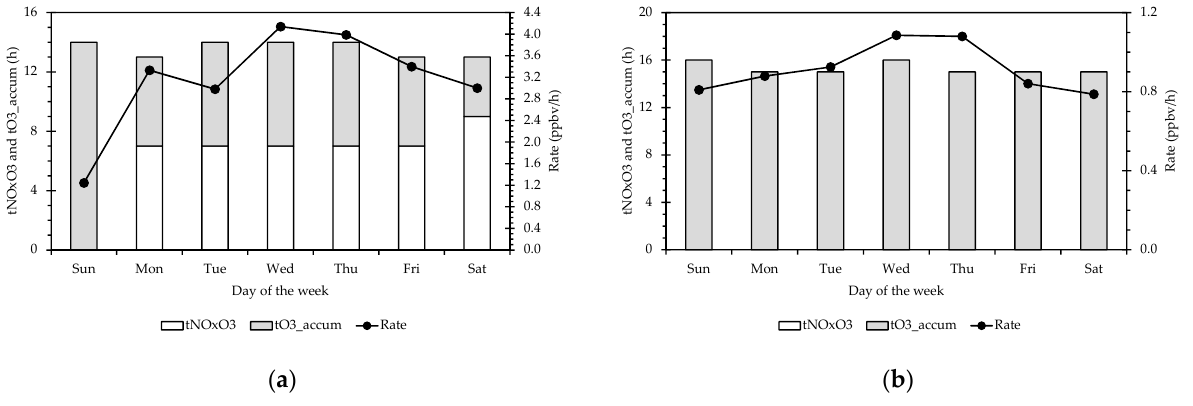
Figure 4. The day-of-week variation of the morning NO-O 3 crossover time (tNOxO3), the O 3 accumulation time (tO3_acc) (h), and the O 3 accumulation rate (ppbv/h) for ( a ) Queens College (Site #10) and ( b ) Chester (Site #4).